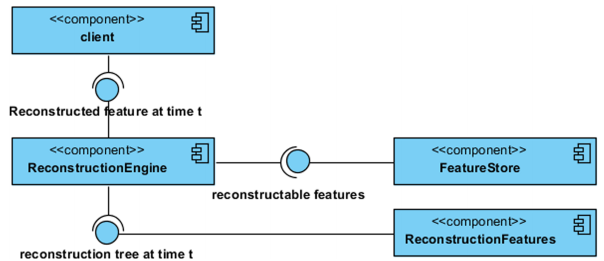
Fig. 25. Component diagram of reconstruction